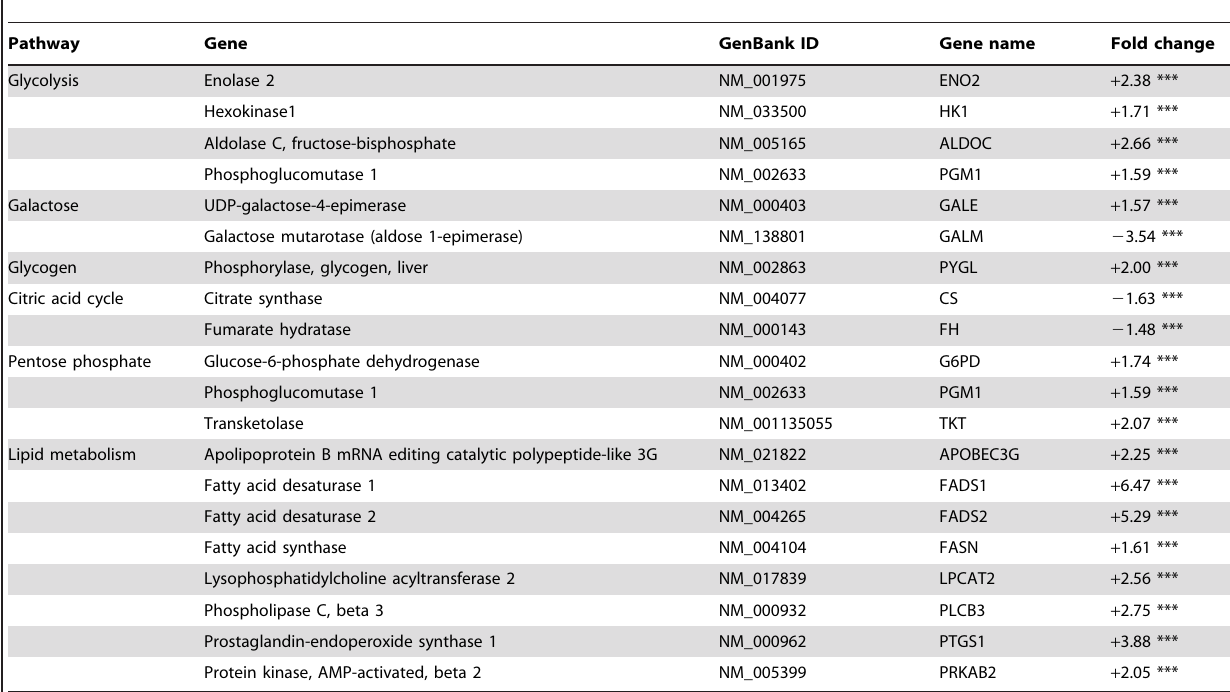
Table 2. Effect of Ets-1 over-expression on glycolysis, glycolytic feeder pathways, and lipid metabolism.